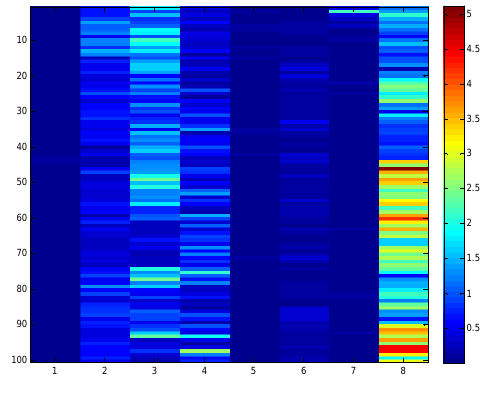
Figure 4. Variance of parameter entropy using 25 windows